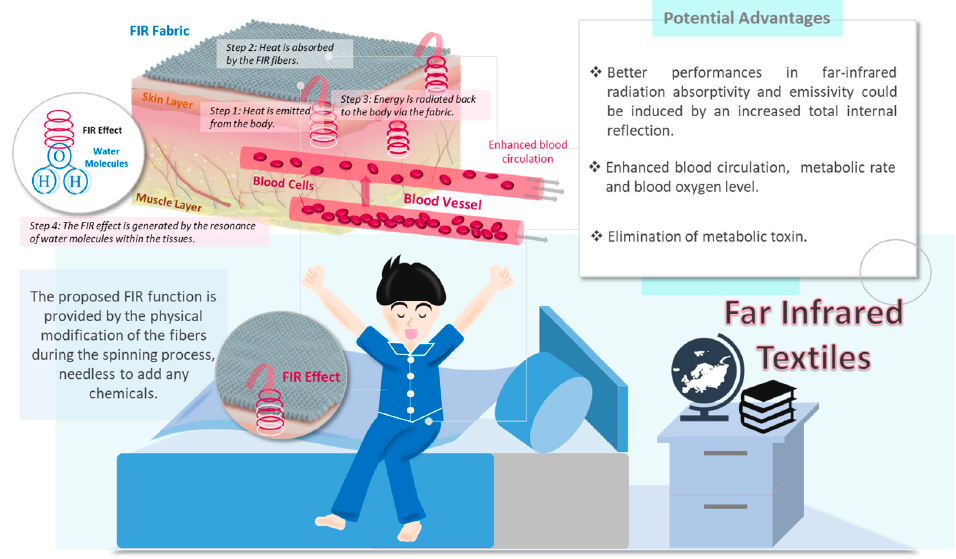
Figure 1. Schematic diagram of the far infrared textiles and the potential advantages.